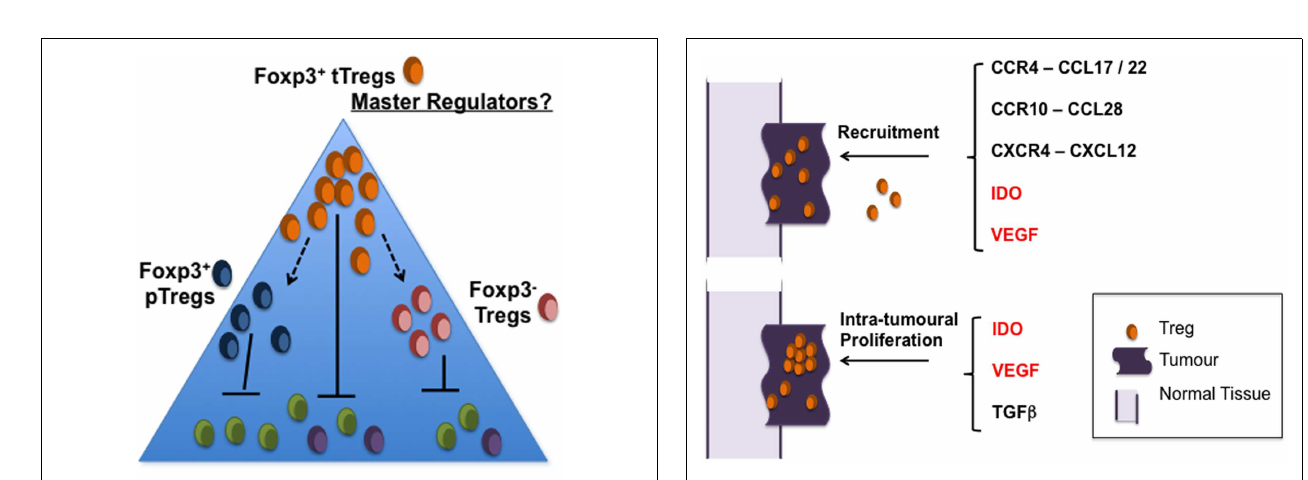
FIGURE 2 | Pathways ofT reg enrichment in tumors . Studies thus far indicate that selective migration ofT reg and preferential proliferation of t Treg result in their accumulation in tumors – the main pathways identified thus far are indicated. Mechanisms promoting both recruitment and proliferation are indicated in